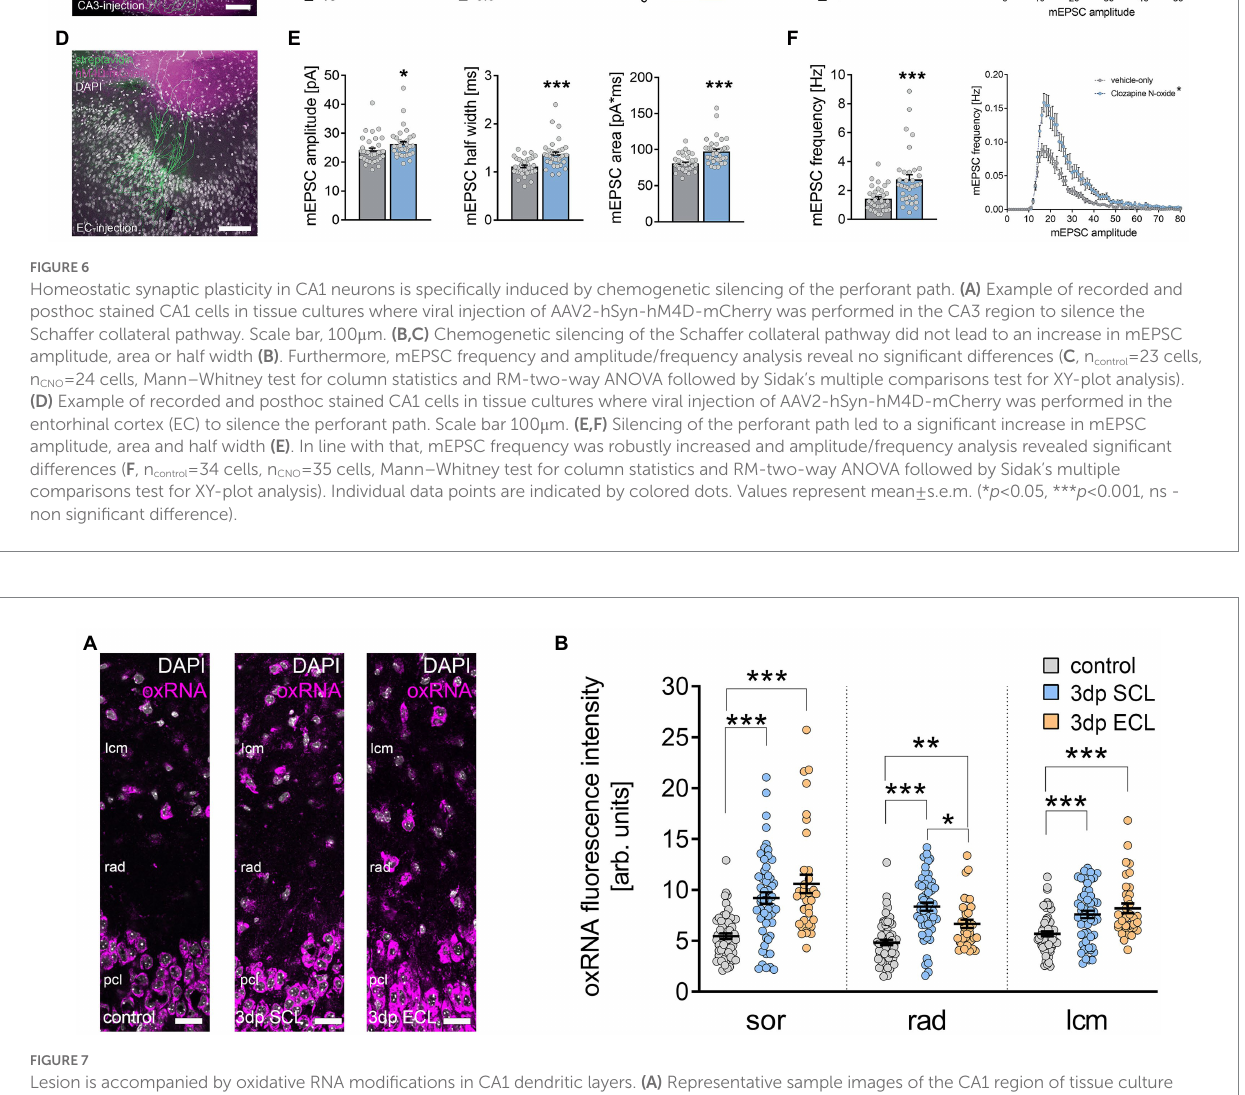
CA1 pyramidal neurons after distinct pathway lesions, i.e., SCL and ECL. Organotypic tissue cultures are characterized by their laminar organization of hippocampal pathways and cortico-hippocampal projections in steady-state conditions (Frotscher and Heimrich, 1993; Heimrich and Frotscher, 1993) that resemble the in vivo architecture of synapses at different levels (Maus et al., 2020). Consistent with previous work involving the dentate gyrus (Vlachos et al., 2012, 2013b), (i) microglia accumulation, (ii) degeneration of presynaptic